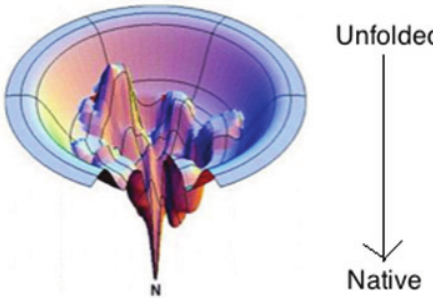
Figure 1. The funneled energy landscape representing the process of going from unfolded state to native state. (Taken from ref. [9] and